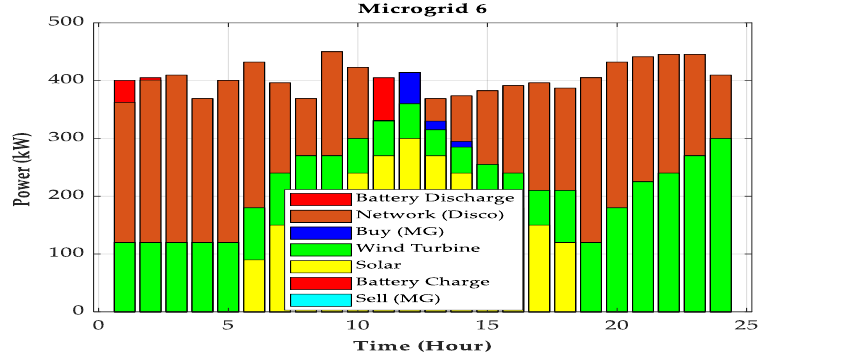
Energies 2022 , 15 , x FOR PEER REVIEW Figure 26. Impact of power-sharing on MG 6. Figure 26. Impact of power-sharing on MG 6.